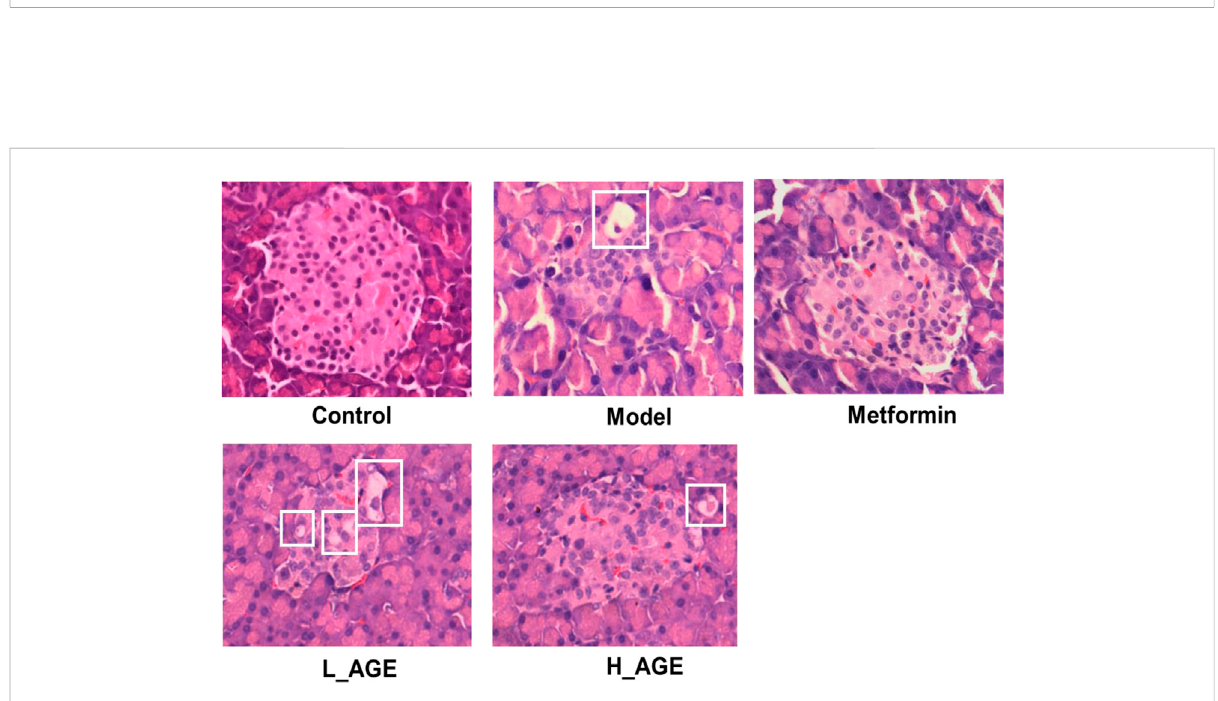
FIGURE 3 Pathological changes of H & E staining in pancreatic tissue of rats